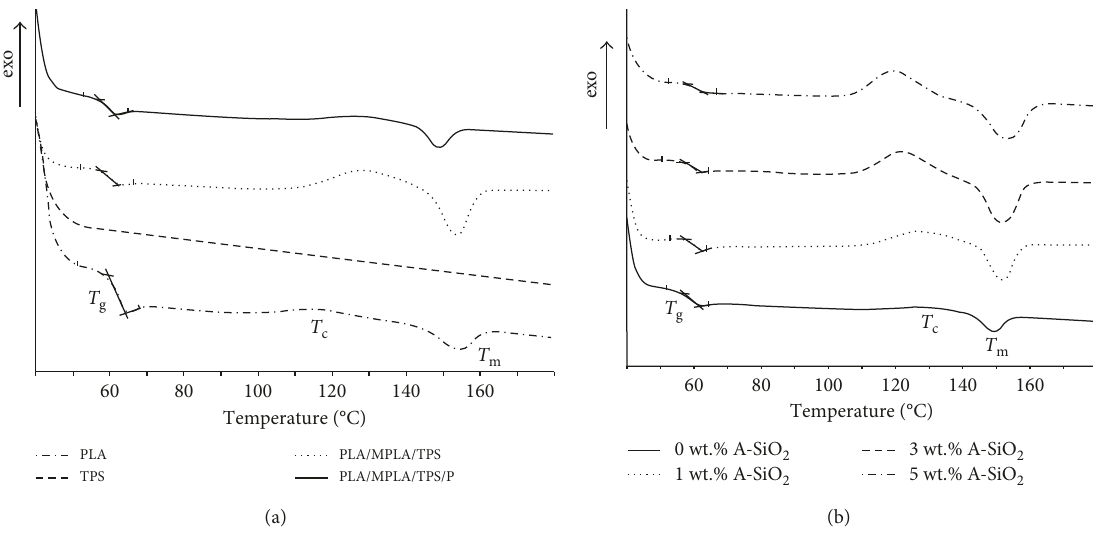
Figure 8: DSC curves of PLA, TPS, and various blends (a) and composites (b); second heating scan. Table 3: DSC data of PLA, TPS, and various blends and composites.